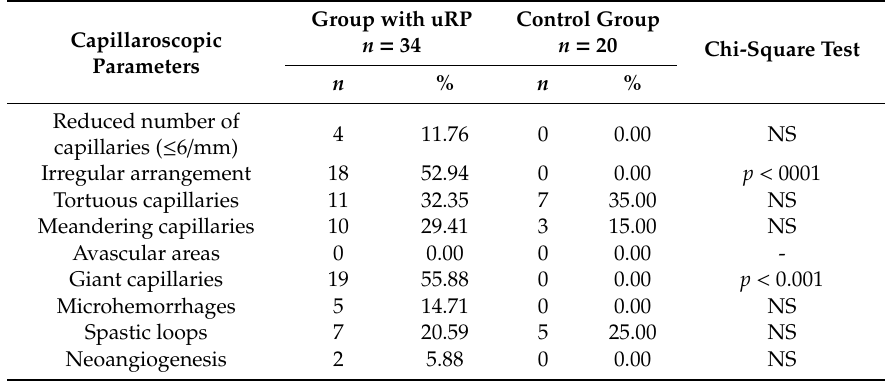
Table 5. Assessment of the qualitative capillaroscopic parameters in children and adolescents with undi ff erentiated Raynaud’s phenomenon (uRP) compared with the control group.